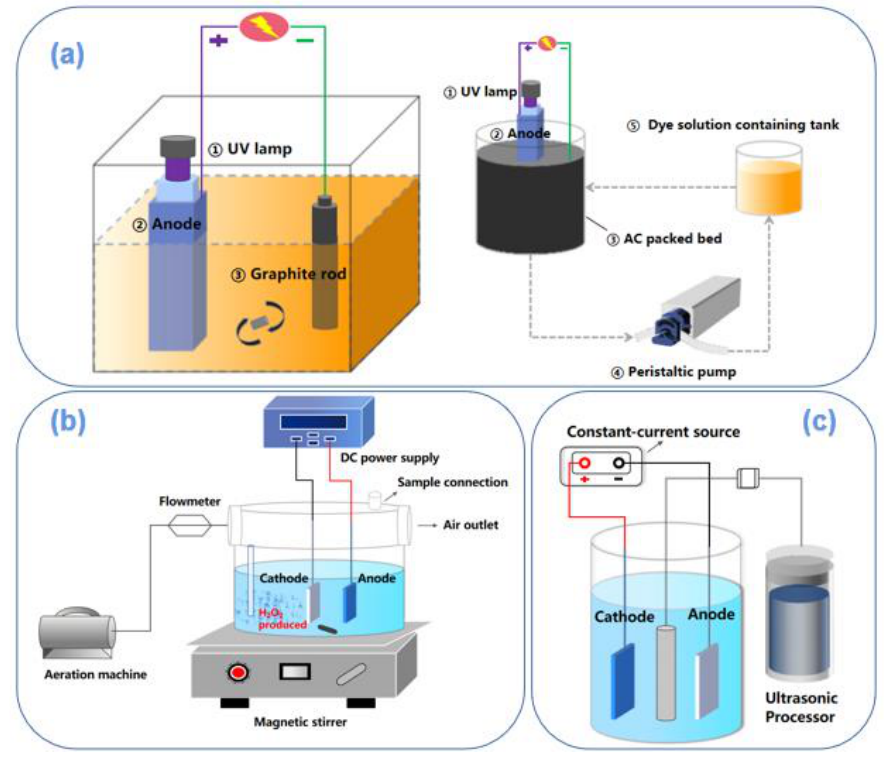
Figure 6. Photoelectro-Fenton coupling device [108] ( a ); electro-Fenton coupling device [107] ( b ); ul- trasonic strengthening coupling device ( c